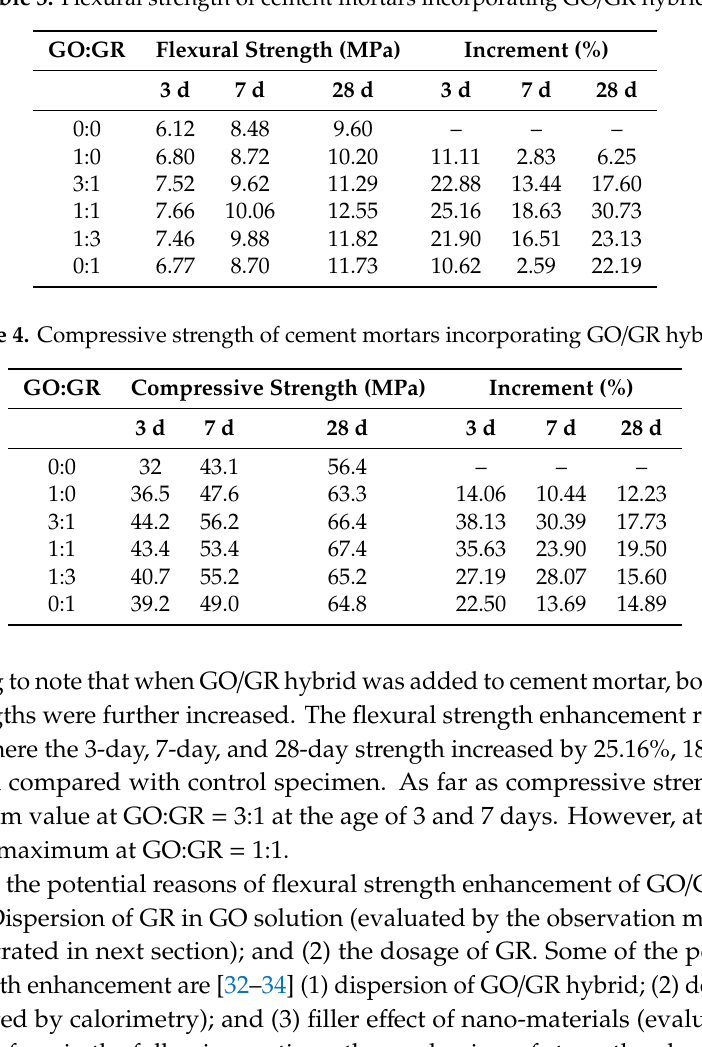
Table 3. Flexural strength of cement mortars incorporating GO / GR hybrid.